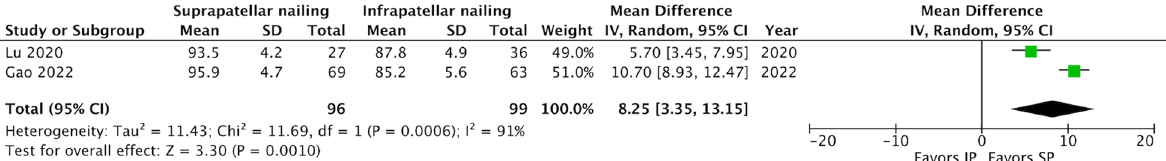
0.001; I 2 91%). AOFAS American Orthopedic Foot and Ankle Society, MD median = =